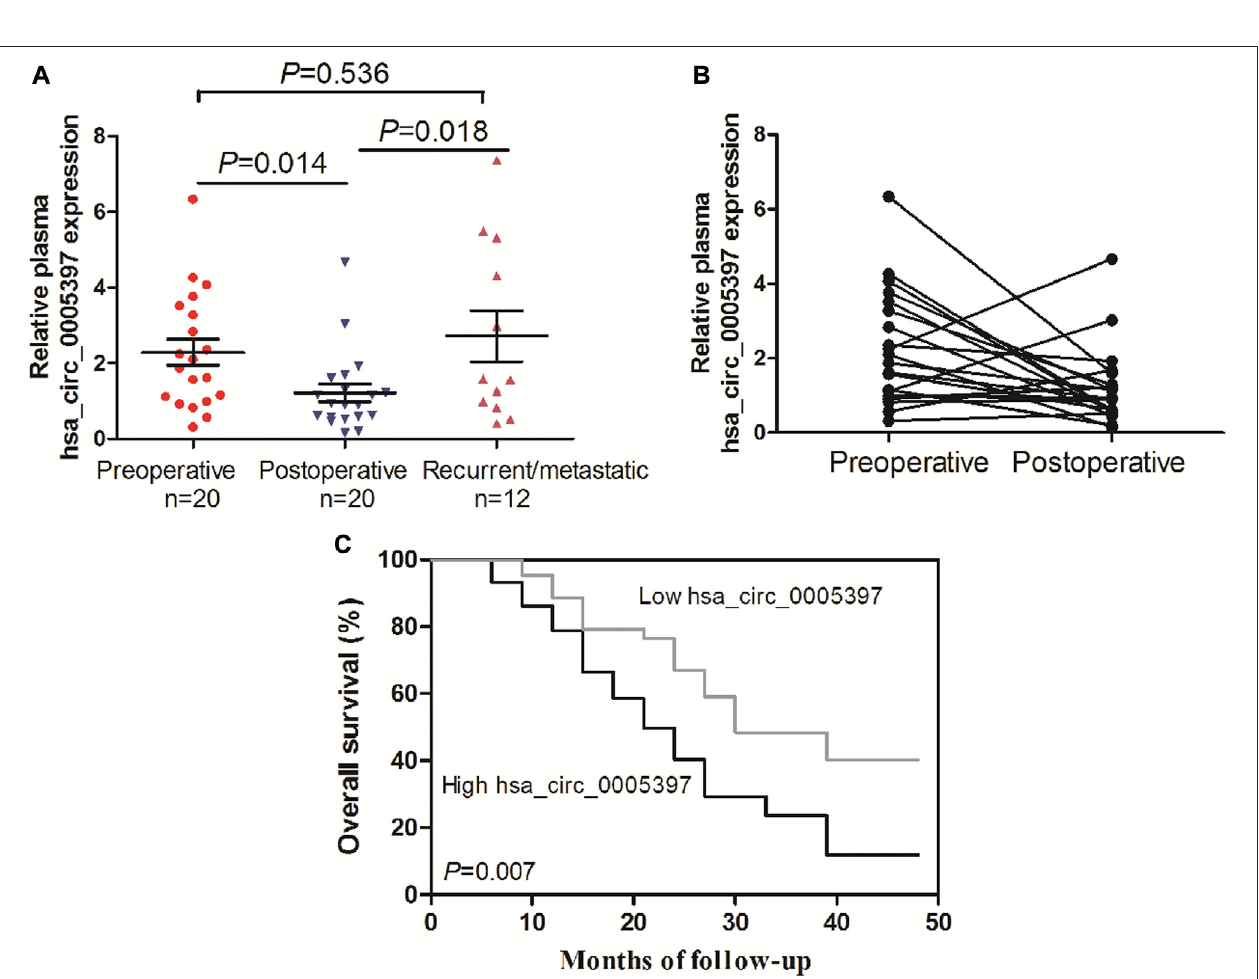
FIGURE6| Dynamicanalysisofplasmahsa_circ_0005397anditsprognosisvalueinpatientswithHCC. (A,B) Theexpressionlevelsofplasmahsa_circ_0005397 were monitored from preoperative, postoperative and recurrent or metastatic HCC patients. (C) Kaplan – Meier survival curve analysis based on the plasma hsa_circ_0005397 expression levels of HCC